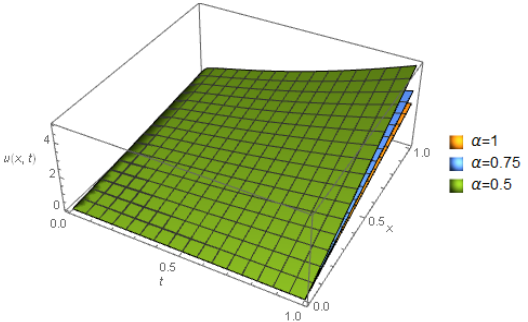
Figure4: Absolute error of example3 at (cid:11) = 1